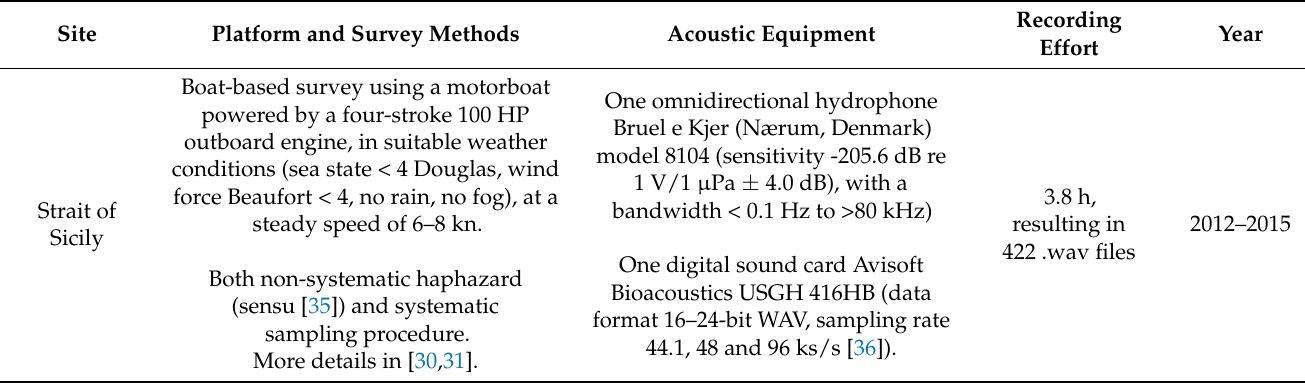
Table 1. Survey platforms and methods for data collection, acoustic equipment, total recording effort and sampling periods for the two research